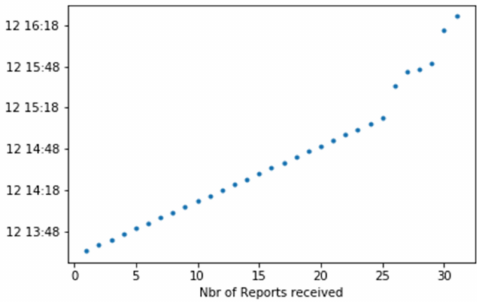
Figure 12. Number of files actually received as a function of time–4 smart meters.